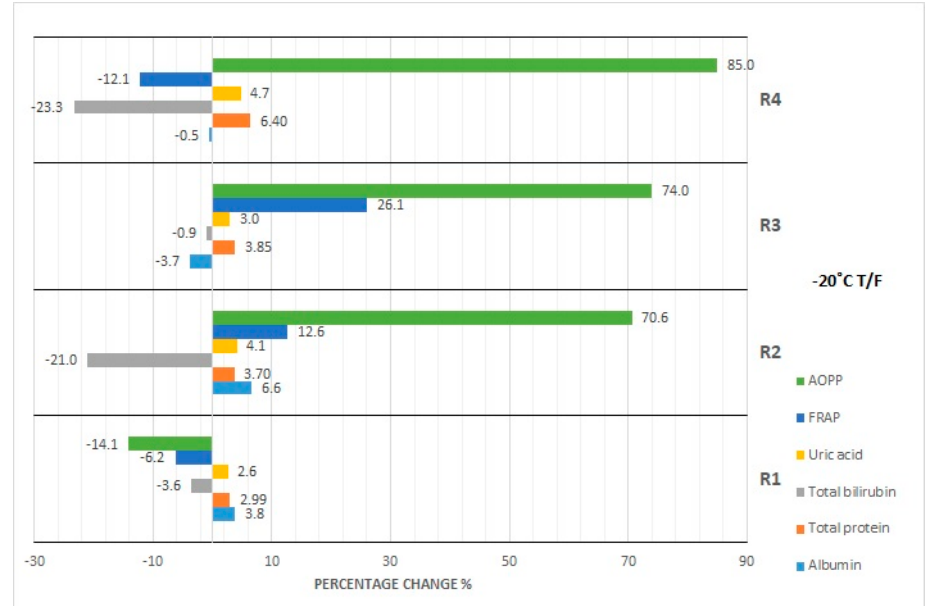
Figure 3. Percentage changes in concentration of selected parameters after storage of serum samples for 1–6 months (1M-6M) at − 80 °C. AOPP—advanced oxidation protein products, FRAP—ferric reducing ability of plasma, UA—uric acid, Bil—bilirubin, TP—total protein, Alb—albumin.